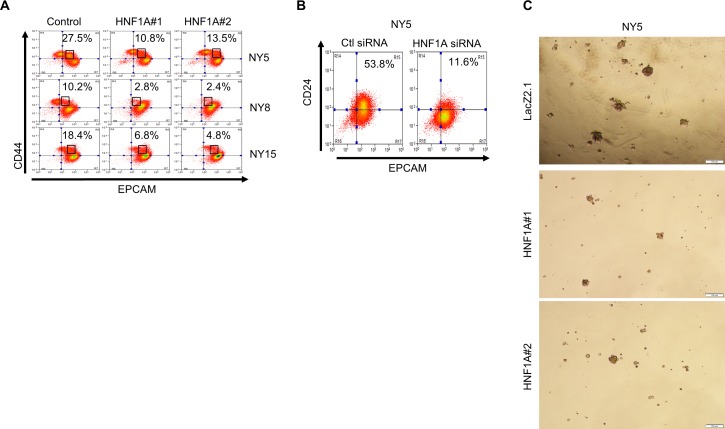
Knockdown of HNF1A depletes CSC numbers and properties in vitro.(A) Surface expression of CD44 and EPCAM in multiple primary PDA cells following HNF1A knockdown. Percentages of P2 cells are indicated. (B, C) Surface expression of CD44 and EPCAM was measured by flow cytometry, and the percentage of (B) CD44High/EPCAMLow (P1) cells and (C) CD44Low/EPCAMHigh (P3) cells are represented (mean ± SEM, n = 3). Statistical difference was determined by one-way ANOVA with Dunnett’s multiple comparisons test. (D) Representative CD24 and EPCAM surface staining in cells following HNF1A knockdown (6 days). (E) NY5 cells expressing LacZ2.1 or HNF1A-targeting shRNAs were grown in tumorsphere media on non-adherent plates (1500 cells/well). Representative images of spheres (100X magnification) are shown.